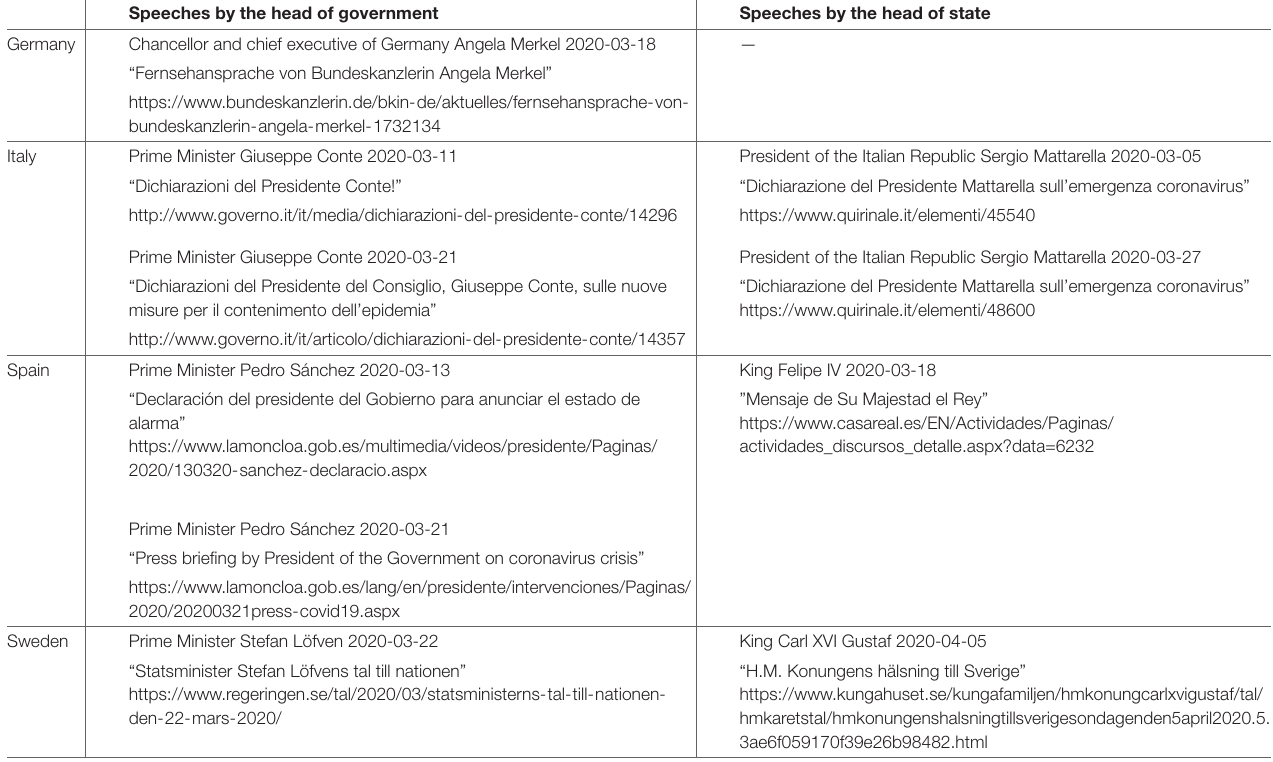
TABLE 1 | List of speeches made by heads of government and heads of state in Germany, Italy, Spain, and Sweden. Speeches by the head of